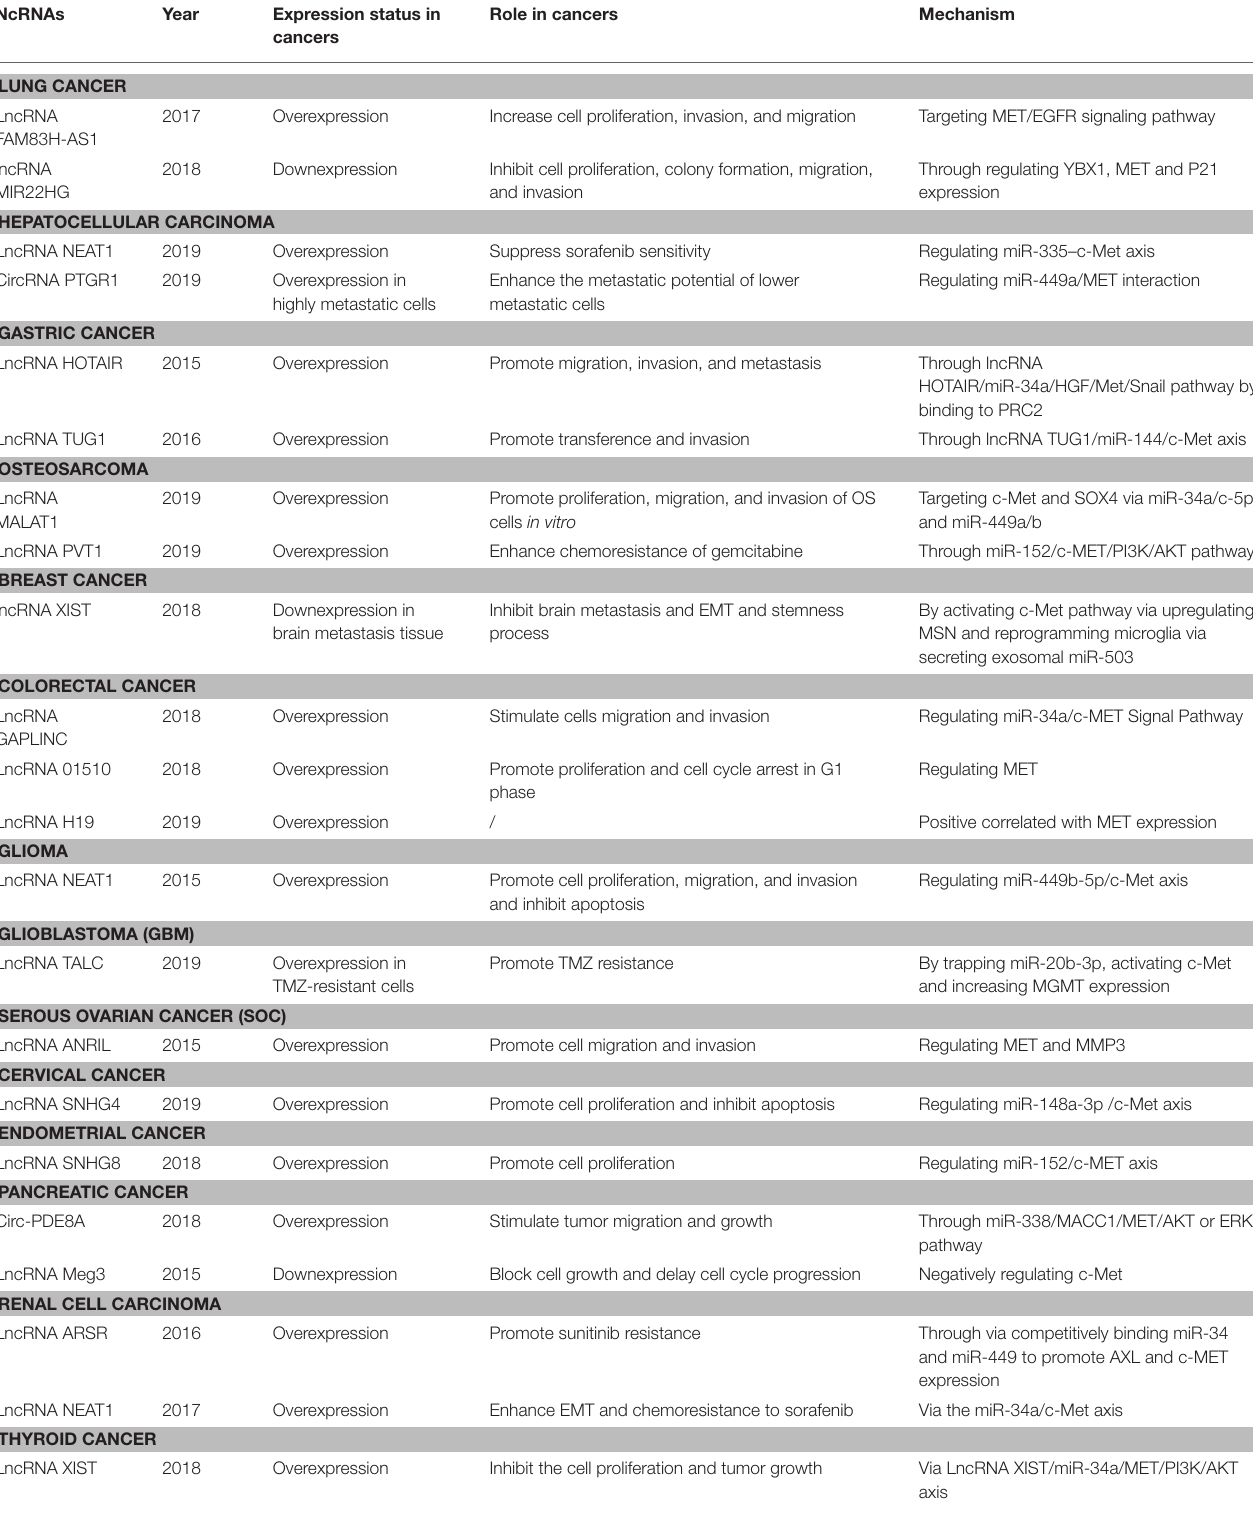
TABLE 2 | The crosstalk between lncRNAs and cricRNAs and HGF/c-Met axis in cancers.